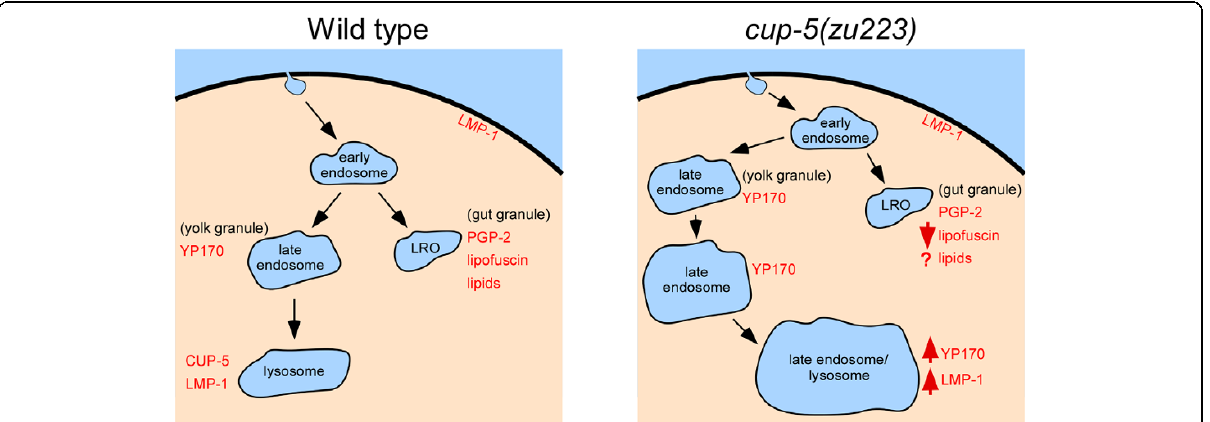
Figure 5 Model of CUP-5 functions in developing intestinal cells . Drawings of intestinal cells showing the markers used in this study in wild type and cup-5 mutant embryos. Organelles are not drawn to actual